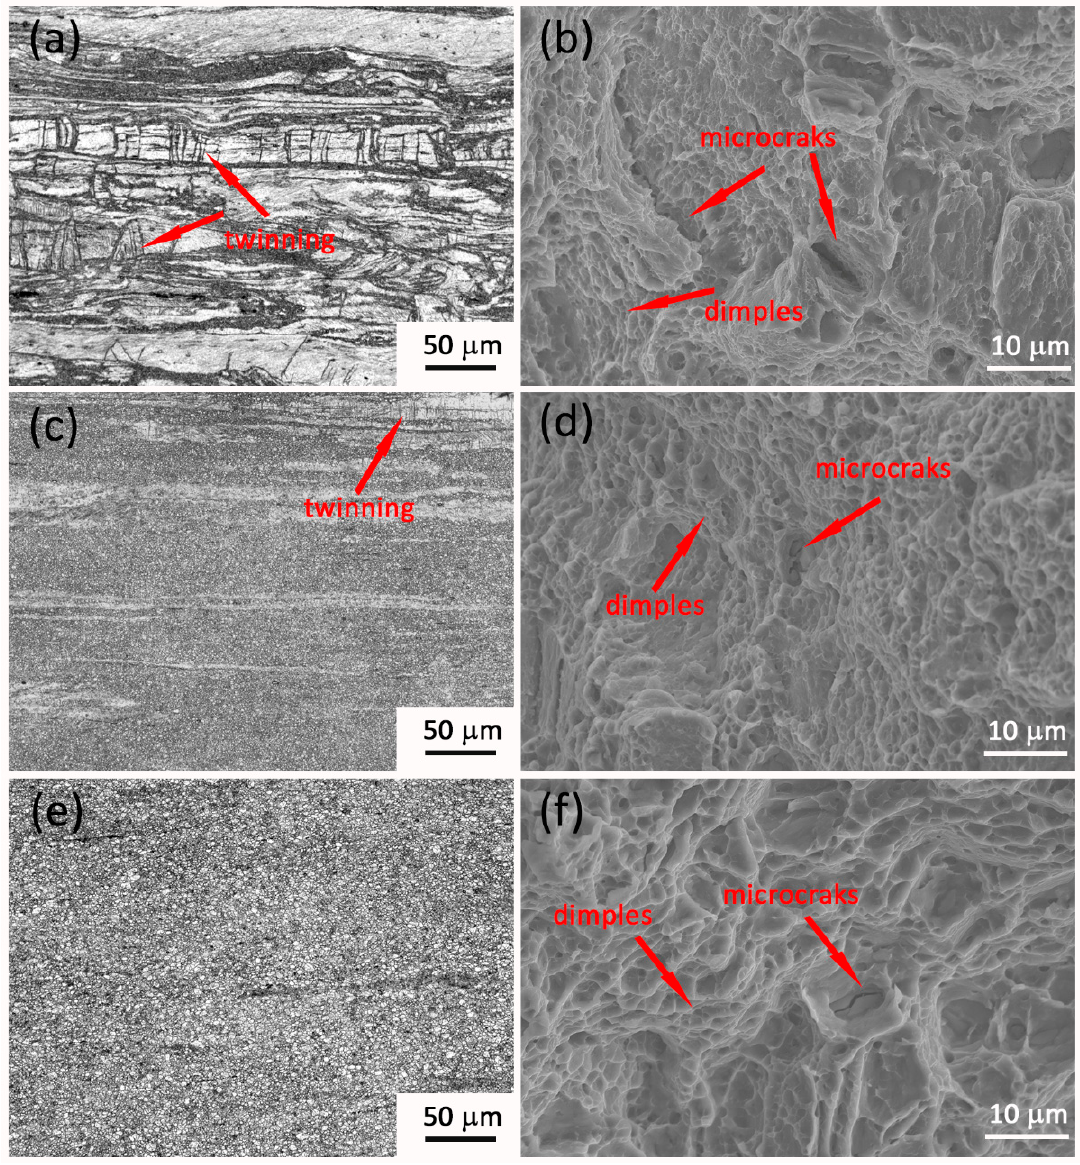
Figure 17. Optical micrographs on the side surface near the fracture and SEM fractography of the ZX10 alloy extruded at: ( a , b ) 300 °C, ( c , d ) 350 °C, and ( e , f ) 400 °C; evidence of twinning, micro-cracks, and dimples are indicated by red arrows.